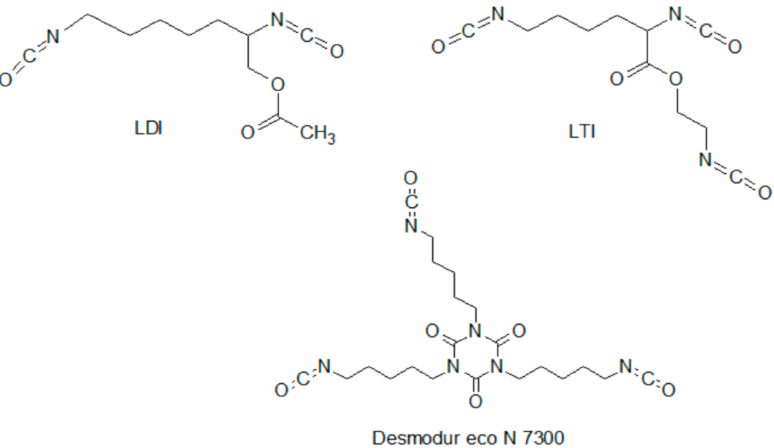
Figure 8. Schemes of the most popular biobased isocyanates: L-Lysine ethyl ester diisocyanate (LDI), L-Lysine ethyl ester diisocyanate (LTI), and Desmodur®eco N